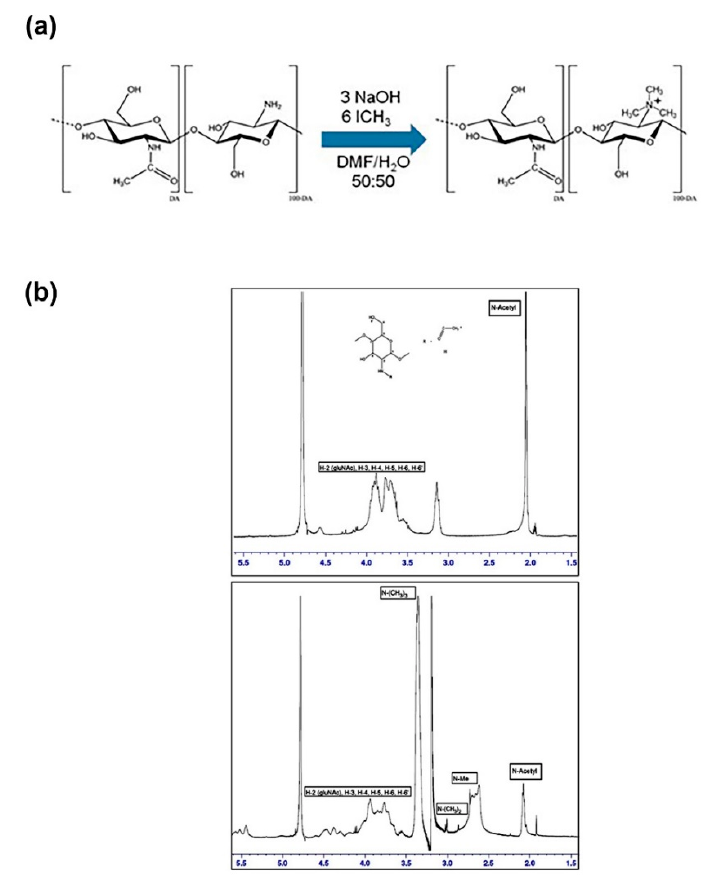
Figure 2. Trimethyl chitosan characterization. ( a ) Scheme of the synthesis and TMC structure. ( b ) 1 H NMR spectrum (600 MHz) of chitosan (upper panel) and TMC in D 2 O at 65 °C. Acetone was used as a reference (2.2 ppm). The main differential groups are indicated on the spectrum.